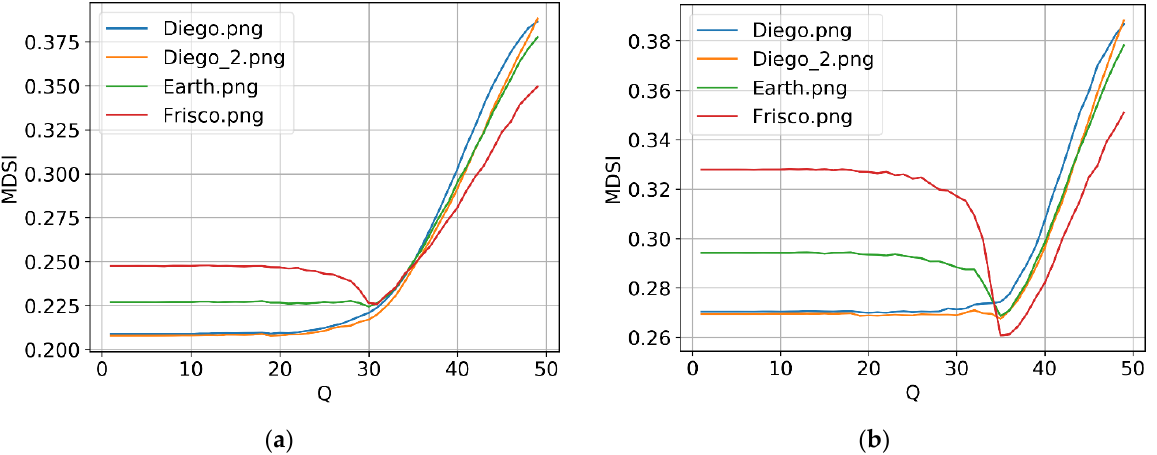
Figure 4. Dependencies of MDSI tc on Q for noise variance equal to 64 ( a ) and 196 ( b ) for the format 4:4:4.